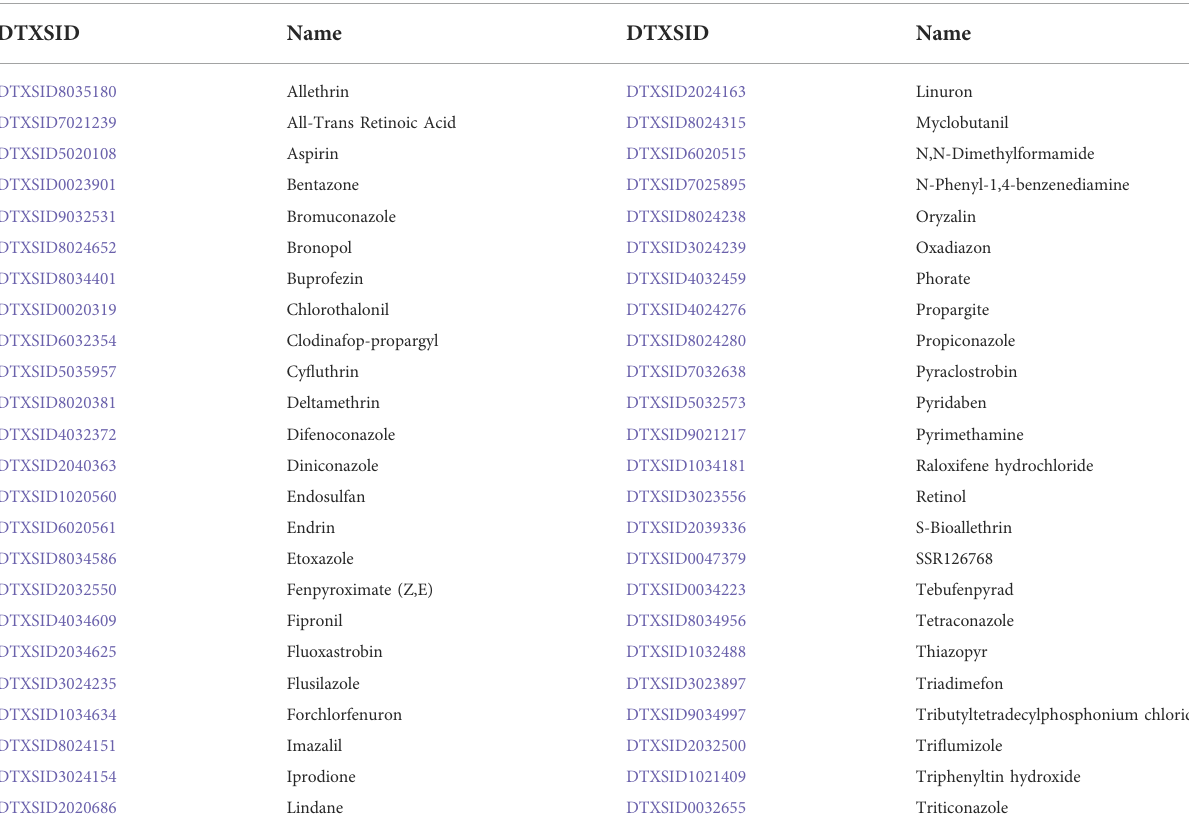
TABLE 2 | 48 chemicals associated with skeletal defects and ATRA Signaling Pathway Disruption (ToxRefDB and